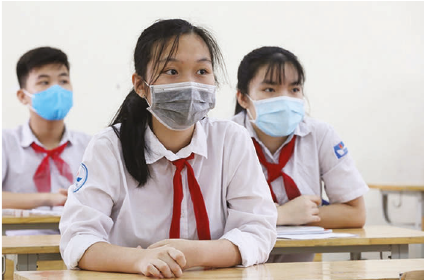
Figure 2: Students wearing masks in class (source: from the